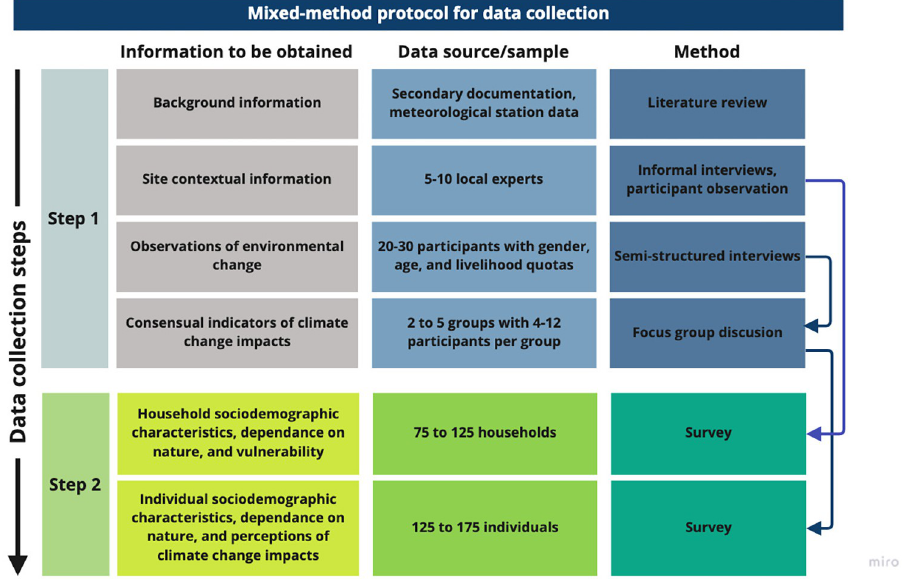
Fig 3. Diagram of data collection protocol displaying the information to be collected, the data source or sample, and the method of data collection. The protocol includes two steps. Step 1 includes the collection of secondary background information, site contextual information, observations of environmental change, and consensual indicators of climate change impacts. Step 2 consists the collection of household and individual characteristics through a survey